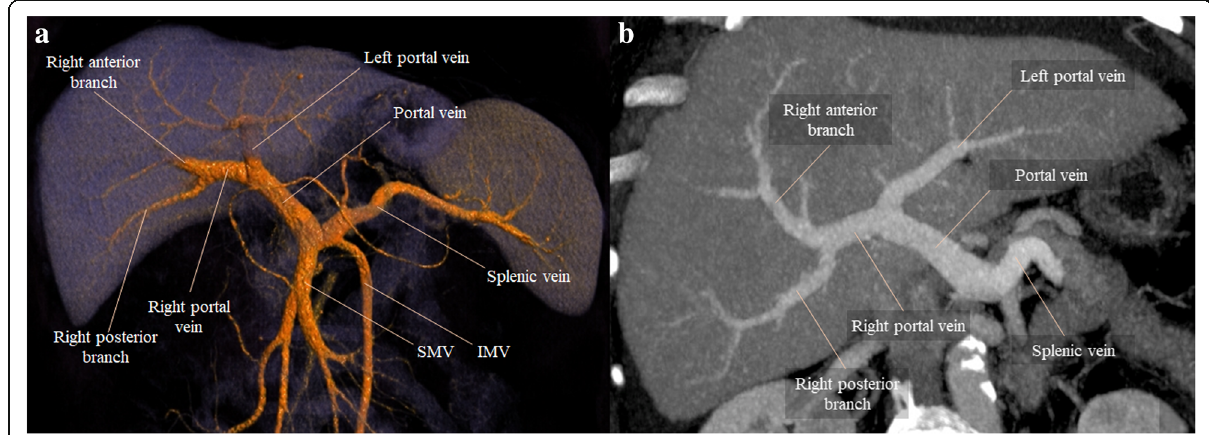
Fig. 2 Normal anatomy of the PVS and the typical branching pattern of the main PV. a Volume rendering technique (VRT) image from late arterial phase contrast-enhanced CT depicting a global view of the PVS. b Maximum intensity projection (MIP) image from portal venous phase contrast-enhanced CT showing the typical branching pattern of the main